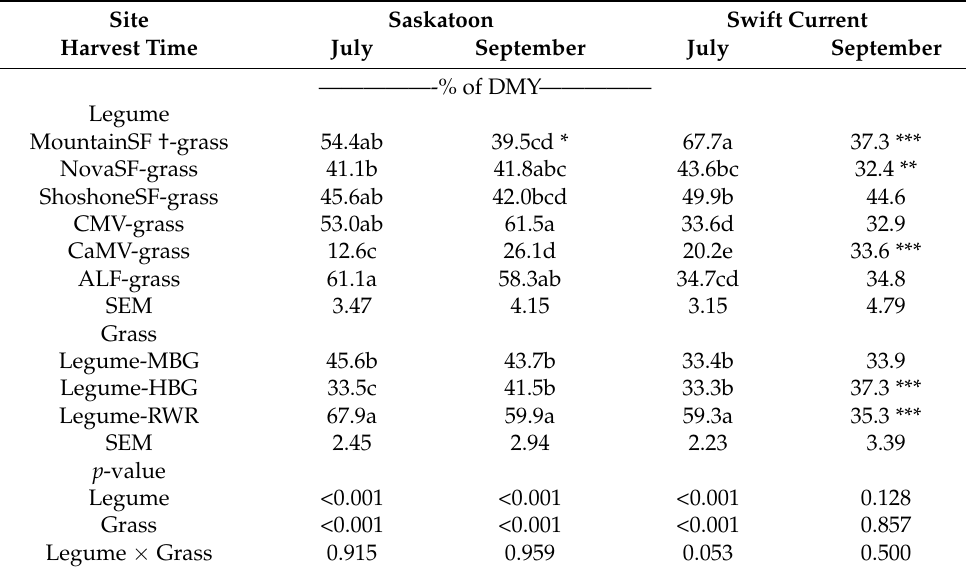
Table 3. Legume contribution to yield of legume-grass binary mixtures in July and September harvest at Saskatoon and Swift Current, Saskatchewan,